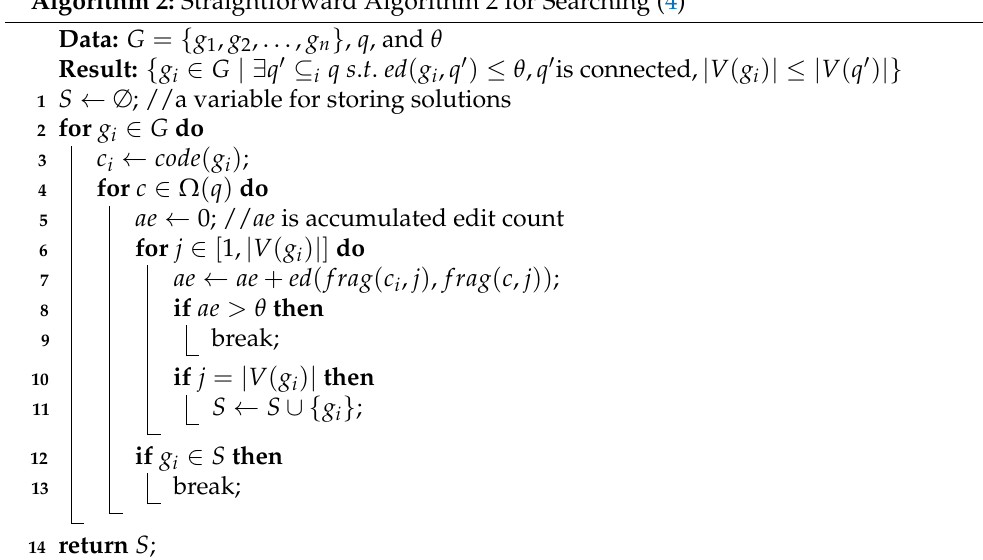
Algorithm 2: Straightforward Algorithm 2 for Searching